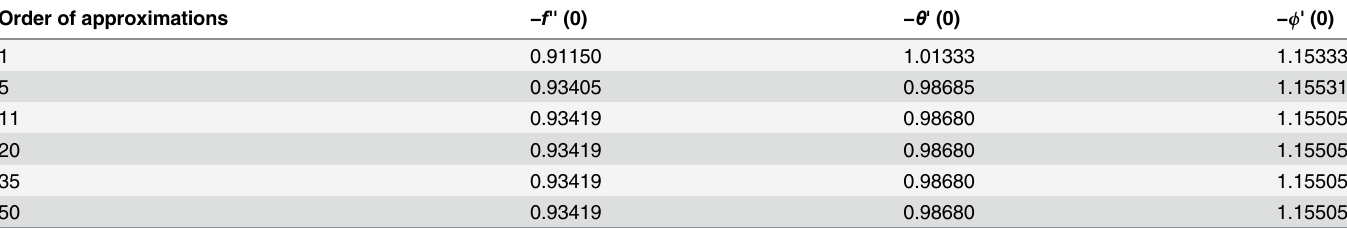
Table 1. Convergence of HAM solutions for different order of approximations when β 1 = β 2 = 0.2 = γ = Rd , λ = 0.1 = N , Pr = 1.0 = Sc , ε 1 = 0.3 = ε 2 and 1 : 0 ¼ ℏ ℏ ¼ ℏ (cid:2) f ¼ (cid:2) y